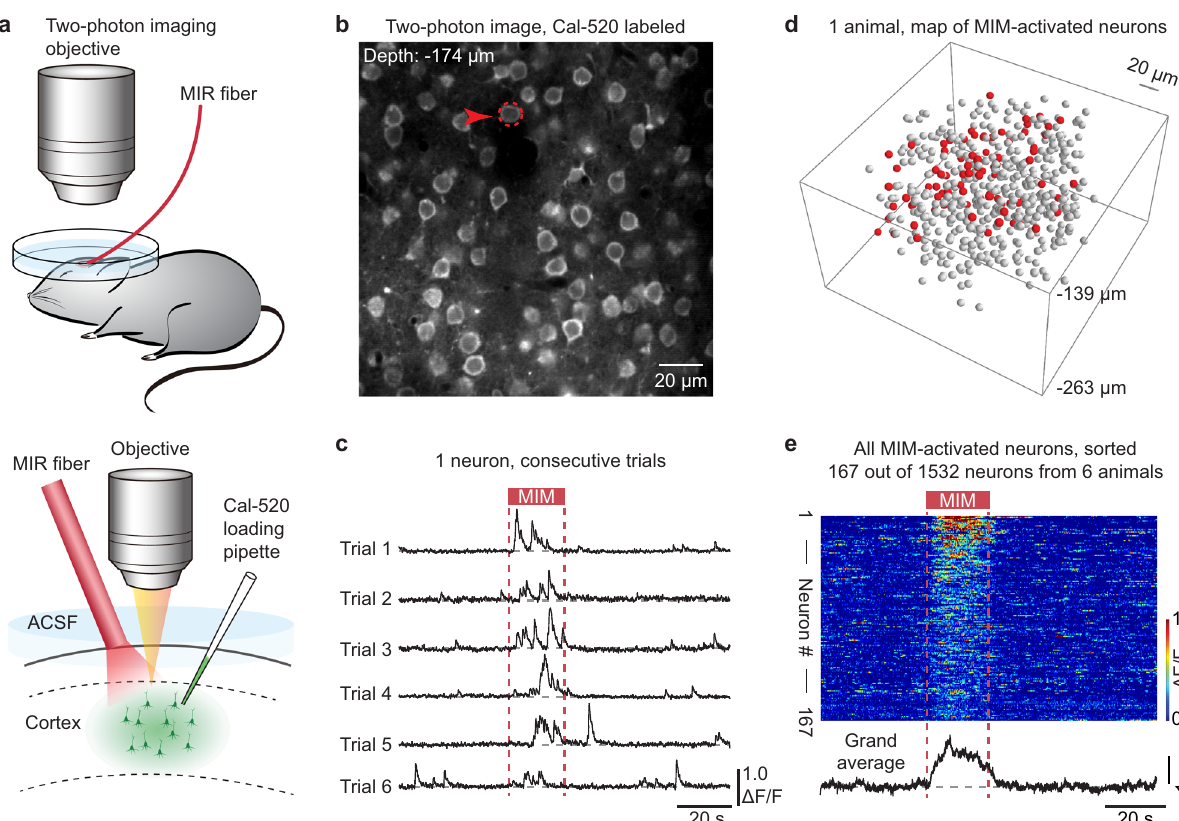
Fig. 2 Spatiotemporal mapping of MIM-activated cortical neurons in vivo. a Upper: cartoon showing the general scheme for the in vivo two-photon imaging experiments. Lower: cartoon showing the con fi guration of the MIR fi ber tip, the two-photon imaging objective, and the Ca 2 + dye loading micropipette. ACSF: arti fi cial cerebrospinal fl uid. b An example in vivo two-photon image (averaged 100 frames). The red arrow and the dashed circle indicate the neuron for which Ca 2 + activity traces are shown in the next panel. c Ca 2 + activity traces of an example neuron (marked in b ) in six consecutive trials. The two red dashed lines indicate the start and the end of the MIM application. d A reconstructed 3D map showing the positions of all MIM- activated neurons (red balls) and unaffected neurons (gray balls) in the imaged volume, consisting of eight focal planes from one example mouse. e Upper: a pseudo-colored plot summarizing the trial-integrated Ca 2 + activity trace for each neuron identi fi ed as MIM-activated. Neurons were sorted by their relative increment of activity level (from pre-MIM to MIM). Lower: a grand average of the Ca 2 + activity traces for all 167 MIM-activated